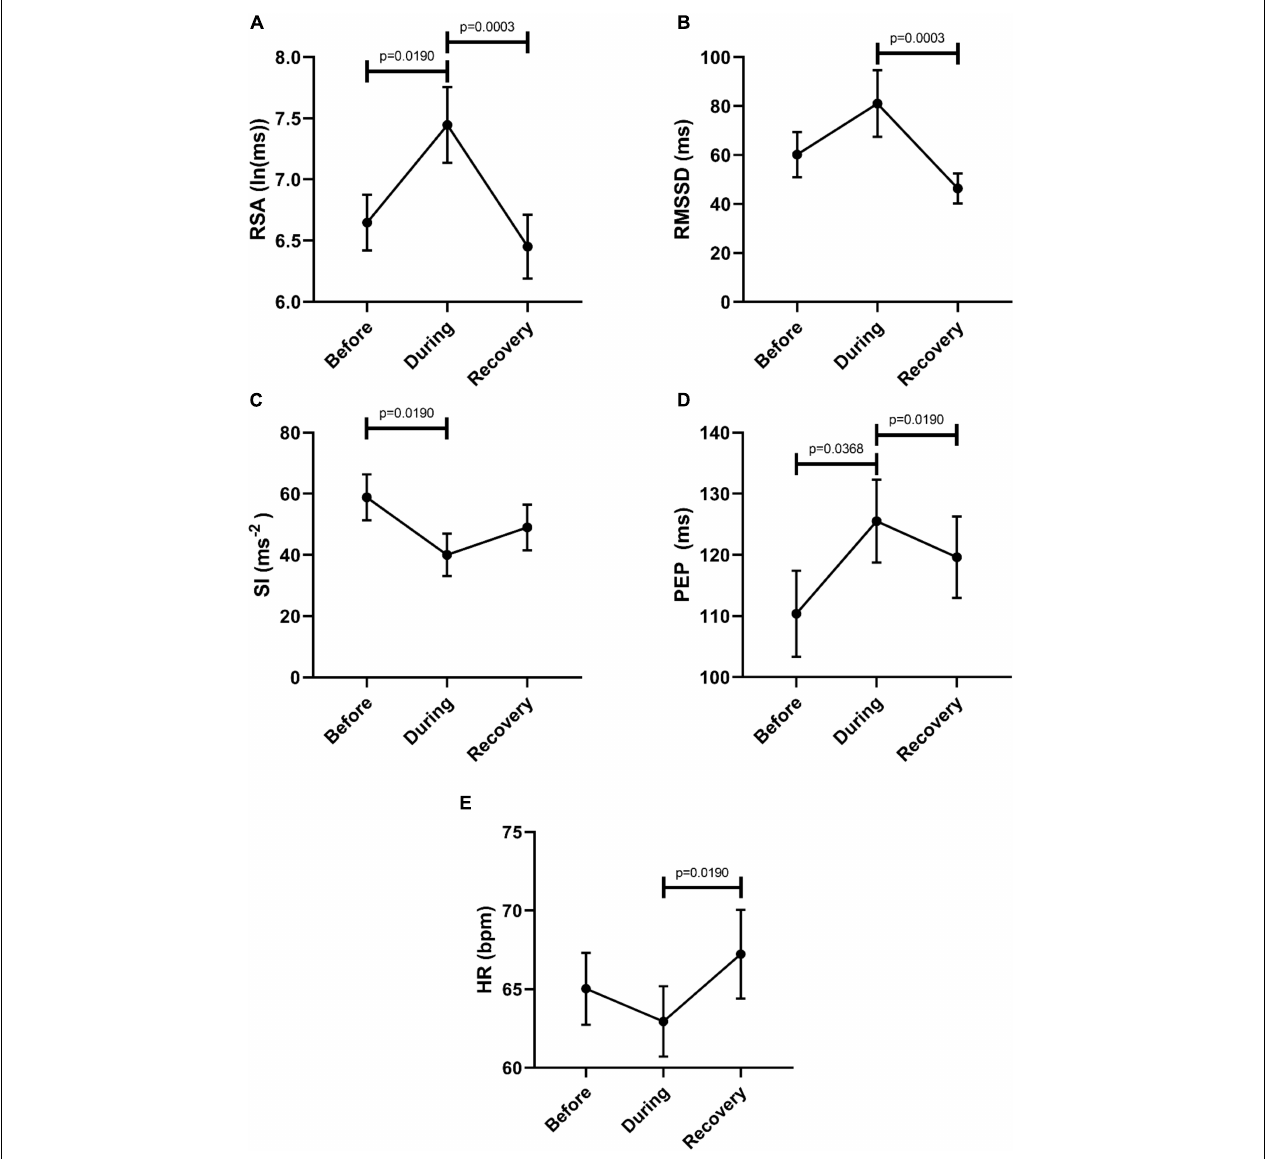
FIGURE 4 | Overall changes in autonomic activity in response to Motor Complexes ( N = 42; n = 9). The following HRV parameters were assessed: RSA (A) , RMSSD (B) , the Baevsky’s Stress Index (SI) (C) , PEP (D) , and heart rate (E) . Data sets were derived by averaging all motor patterns within subjects, hence n = 9). The Friedman test was applied for assessment of significance followed by Dunn’s multiple comparisons test (F-M).